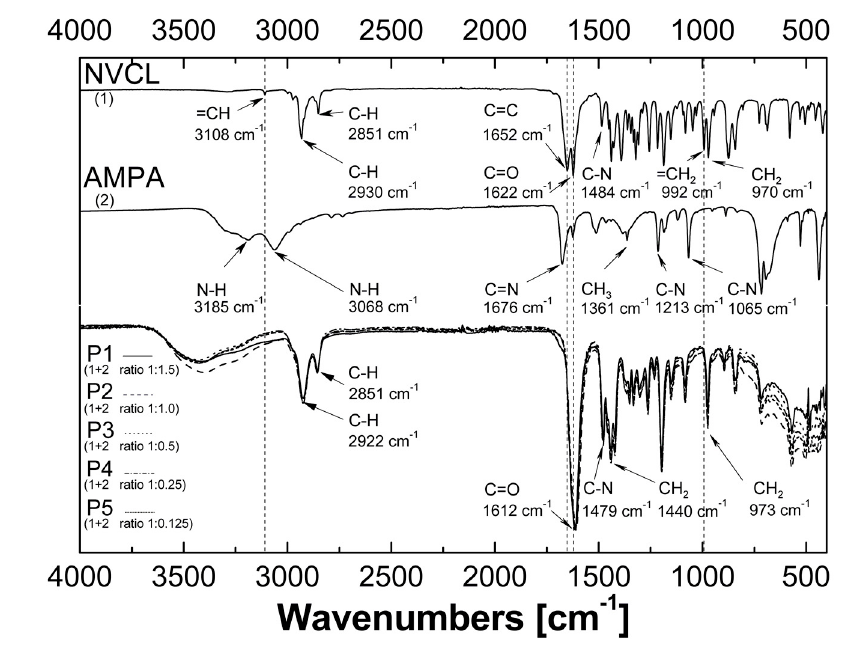
Figure 5. Fourier-transformed infrared spectroscopy with attenuated total reflectance (ATR–FTIR): spectra of monomers N -vinylcaprolactam (NVCL), initiator 2,2 ′ -azobis(2-methylpropionamidine) dihydrochloride (AMPA), and synthesized polymers P1, P2, P3, P4, and P5.